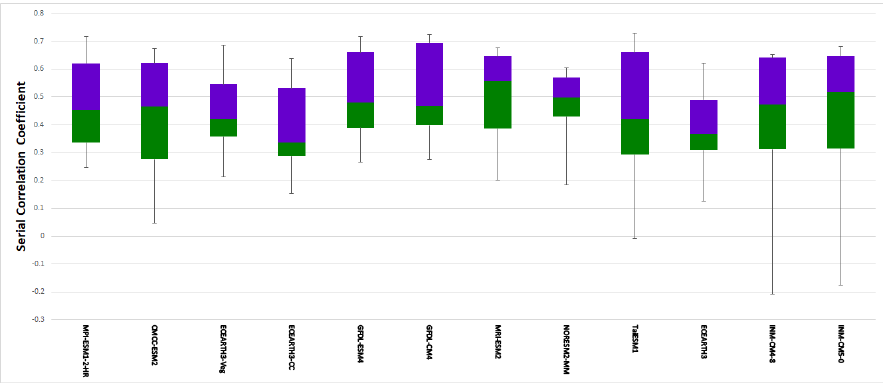
Figure 11. Box plots of monthly Tmin correlation coefficients for each climate mode obtained across all climate